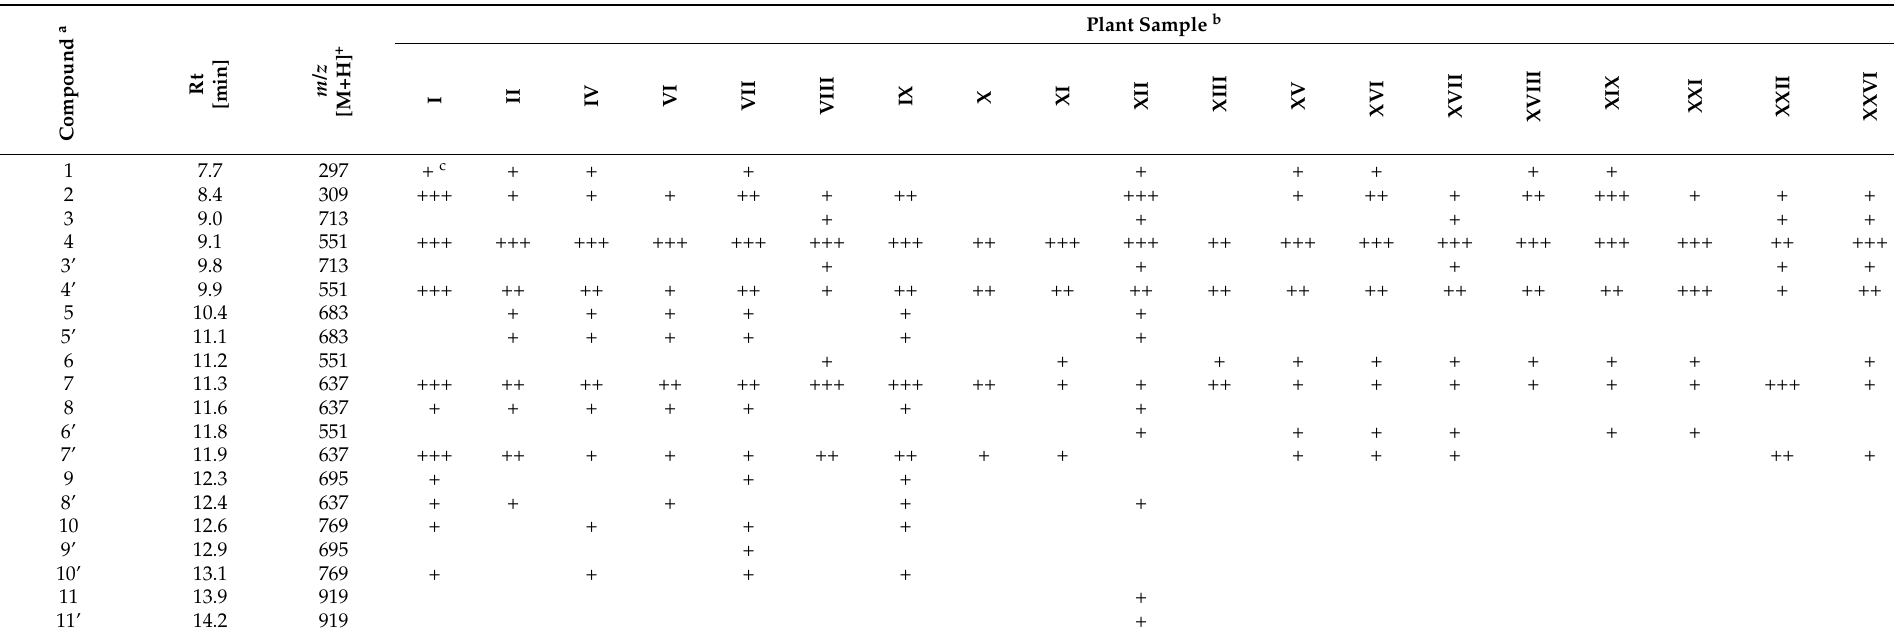
Table 2. Betalains identified in dry extracts of Epiphyllum , Hylocereus, and Opuntia